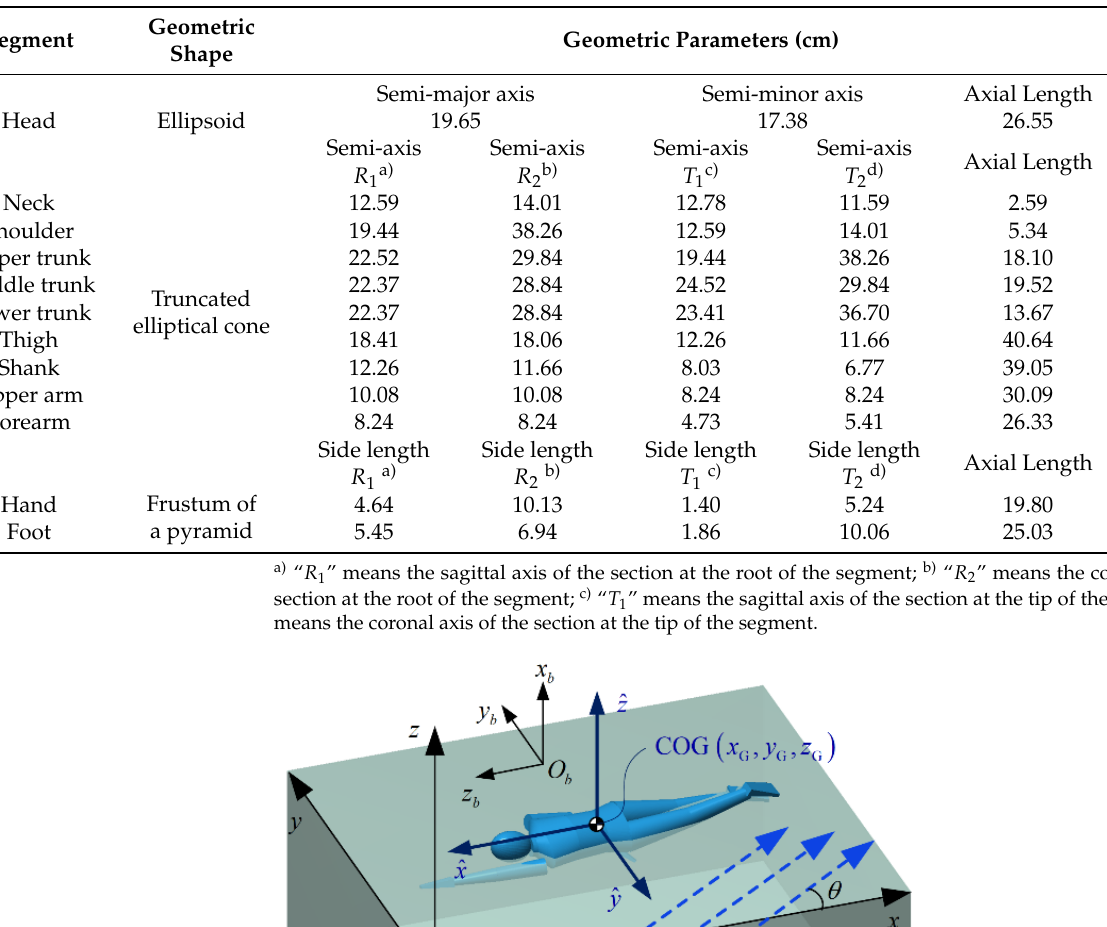
O x y z − (the origin O locates b b b b b